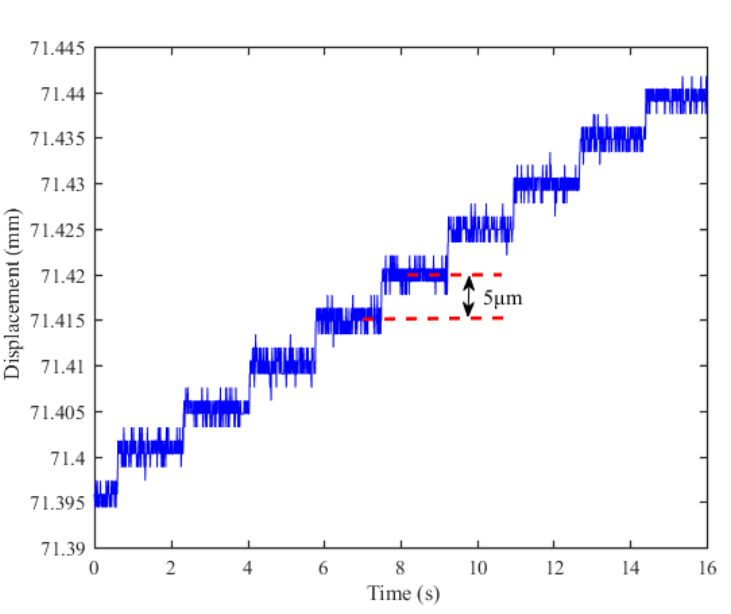
Figure 9. Measurement stability.